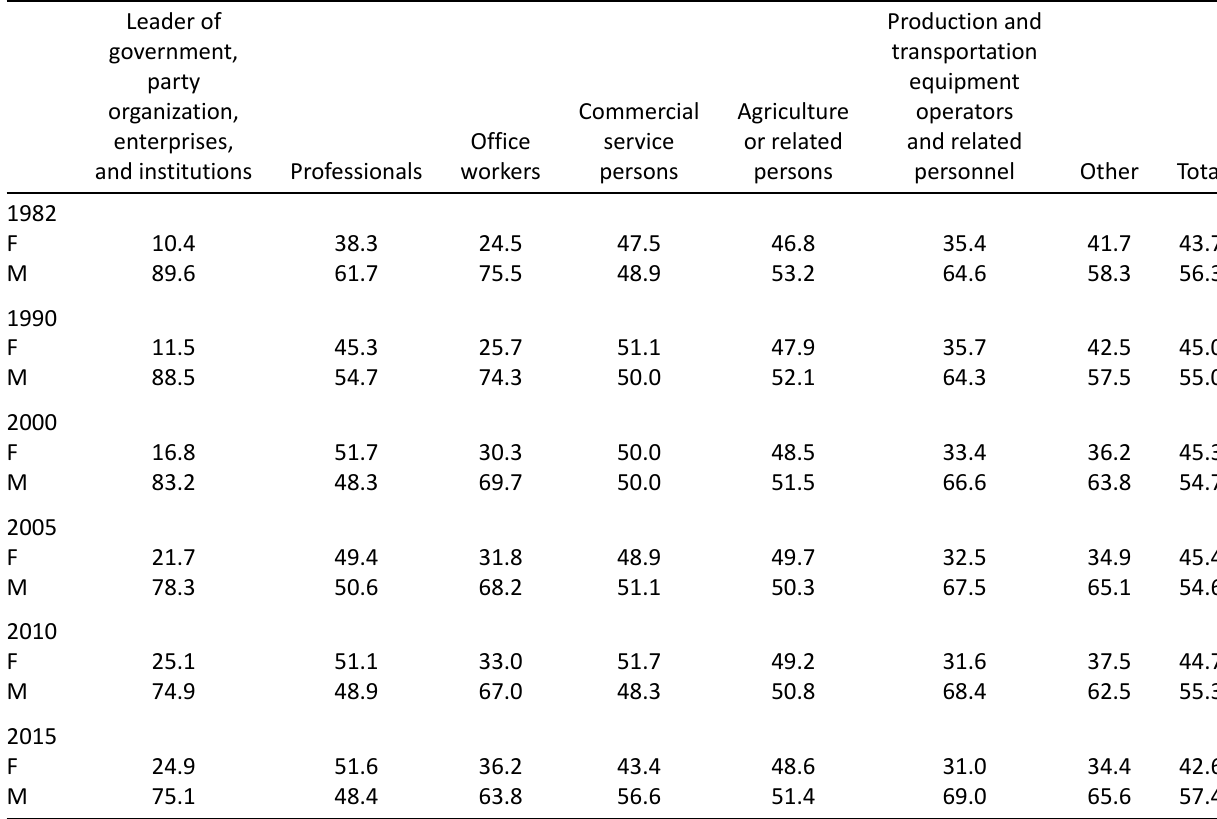
Table 1. Occupations by gender: China 1982–2015 (in percentage). Leader